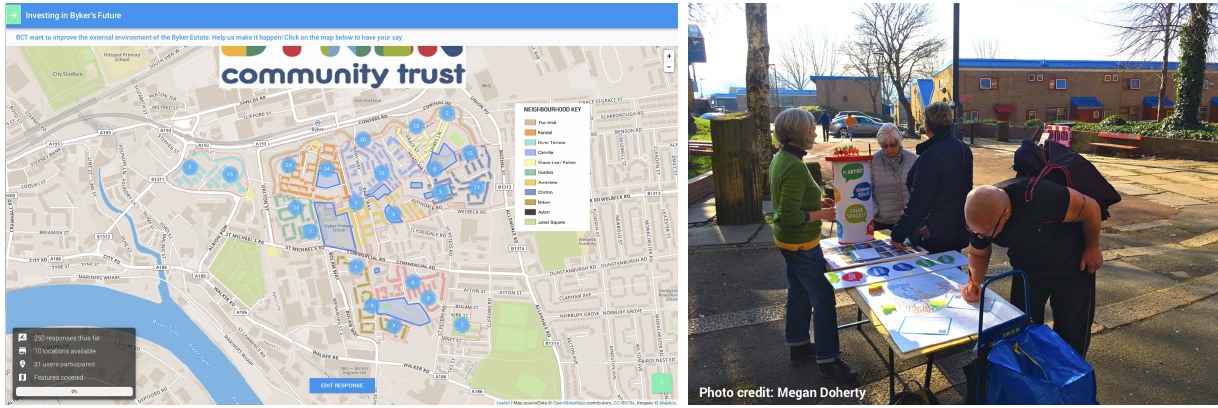
Figure 2. Presentation of the public facing map with various annotations from the public and consultant: the public visual artefact (left) and public event embedding the consultation in a local context